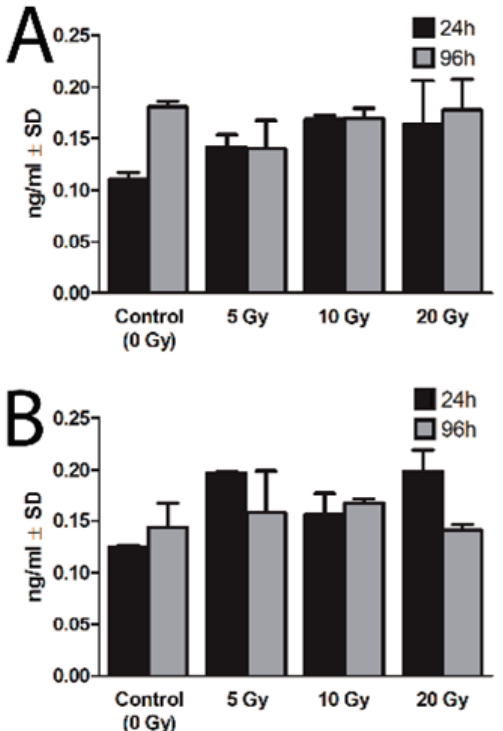
Figure 4. Expression of NIS protein in human thyrocytes cultured with 131 I. The